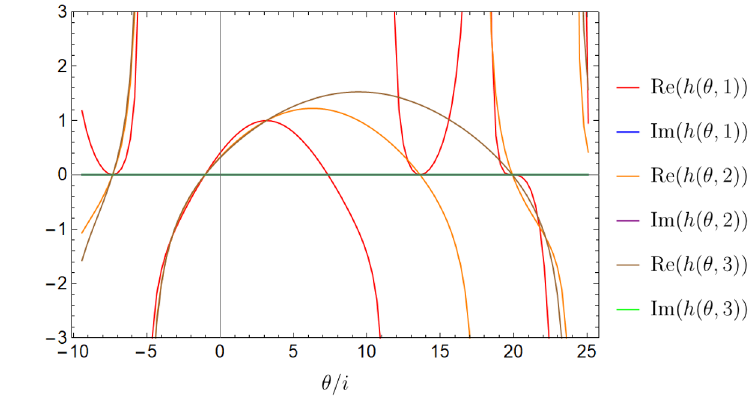
Figure 8 . Plot of the minimal form factor in the n -th replicated theory for imaginary values of the rapidity. For different values of n ( n = 1 , 2 , 3 ) the real and the imaginary part, which is vanishing, are